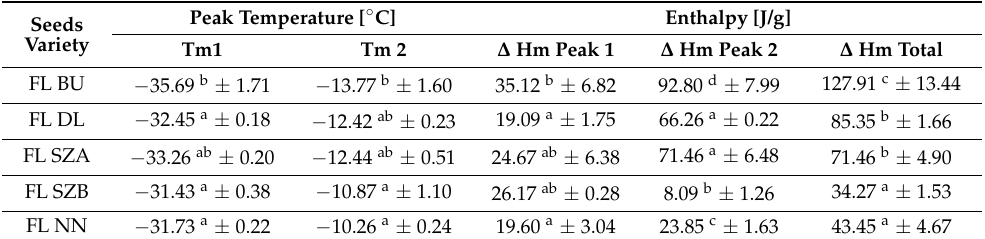
Table 4. DSC thermodynamic parameters of melting process of different cultivars of cold-pressed flaxseed oils obtained by a scanning rate of 1 ◦ C/min.